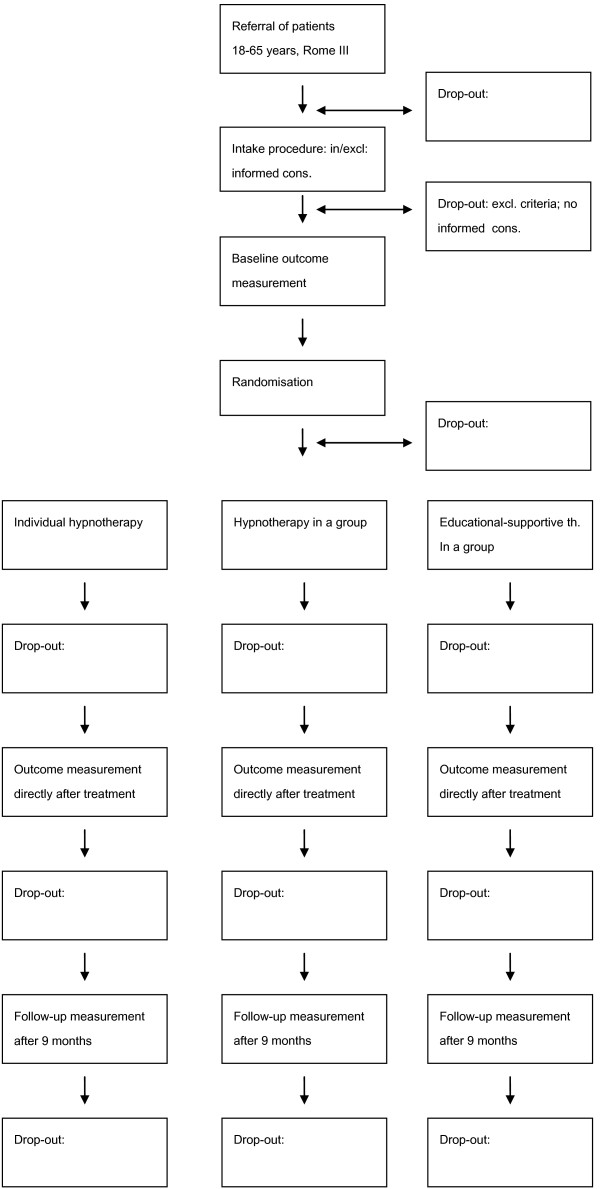
Design of the RCT.